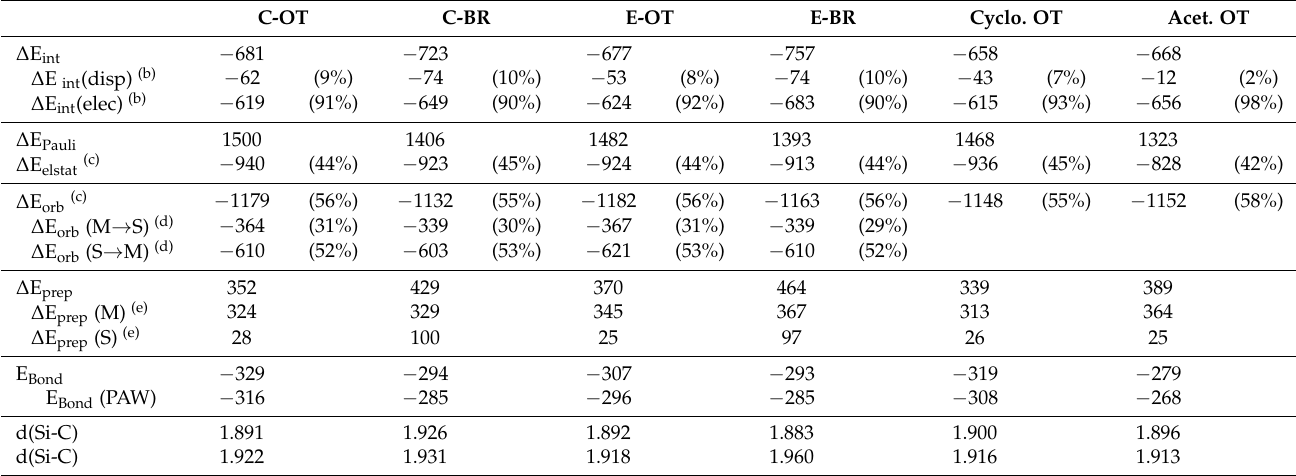
Table 1. Bonding analysis (pEDA) for the four singly bonded structure motifs of ECCO (a) , pEDA values [34] and bond lengths [81] for the parent molecules cyclooctyne and acetylene in the OT mode (Cyclo. OT, Acet. OT) are included.